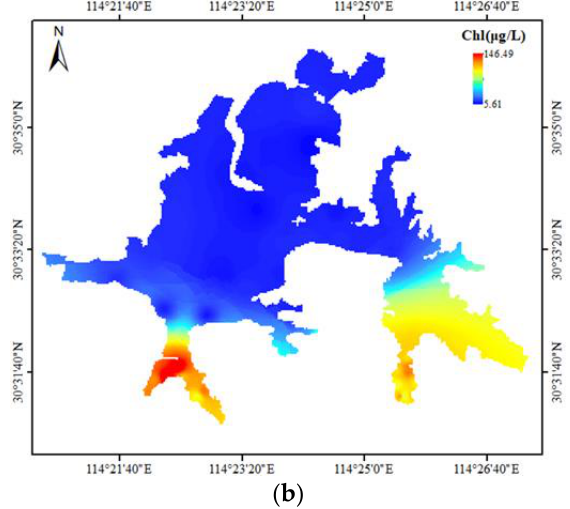
Figure 4. The comparison of chlorophyll a concentration distribution map in Donghu Lake. ( a ) Chlorophyll a concentration distribution map based on observed values. ( b ) Chlorophyll a concentration distribution map based on simulated values.